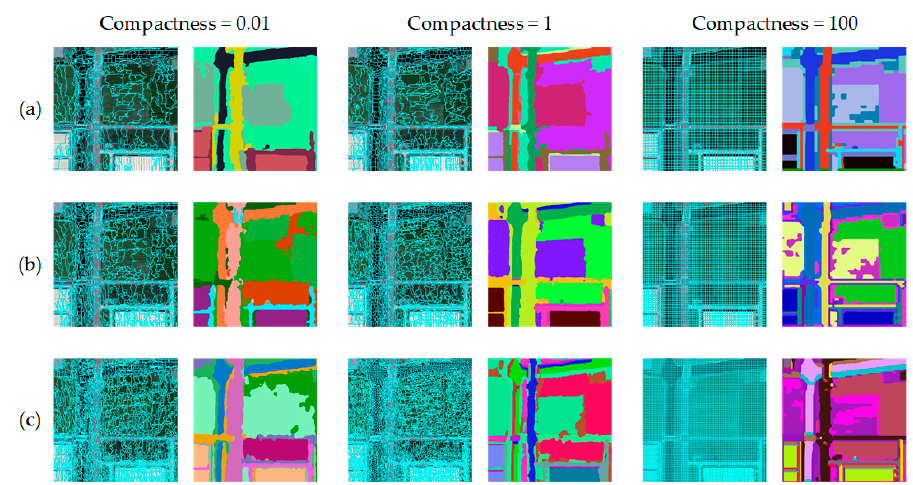
Figure 8. Representative examples of image segmentation results on Shanghai dataset, influenced by diverse settings of our image filter: ( a ) superpixel number equals K/2, ( b ) superpixel number equals K, ( c ) superpixel number equals 2K. The left image in each group is the superpixel-based over-segmentation map, while the right one is the image segmentation result.